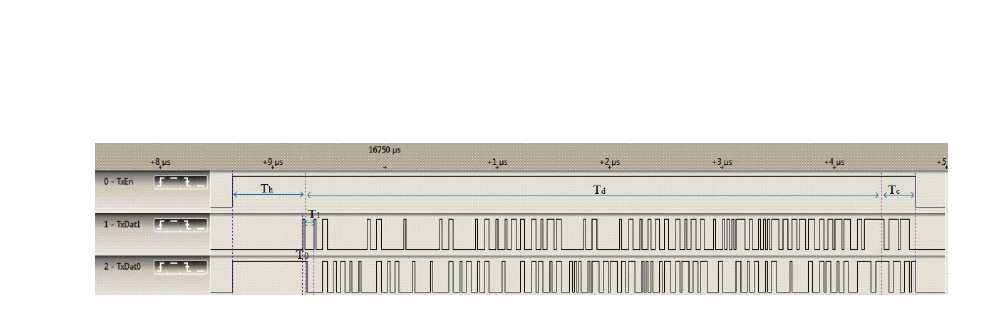
Figure 11: Data Waveform of openMAC, via Salea16.